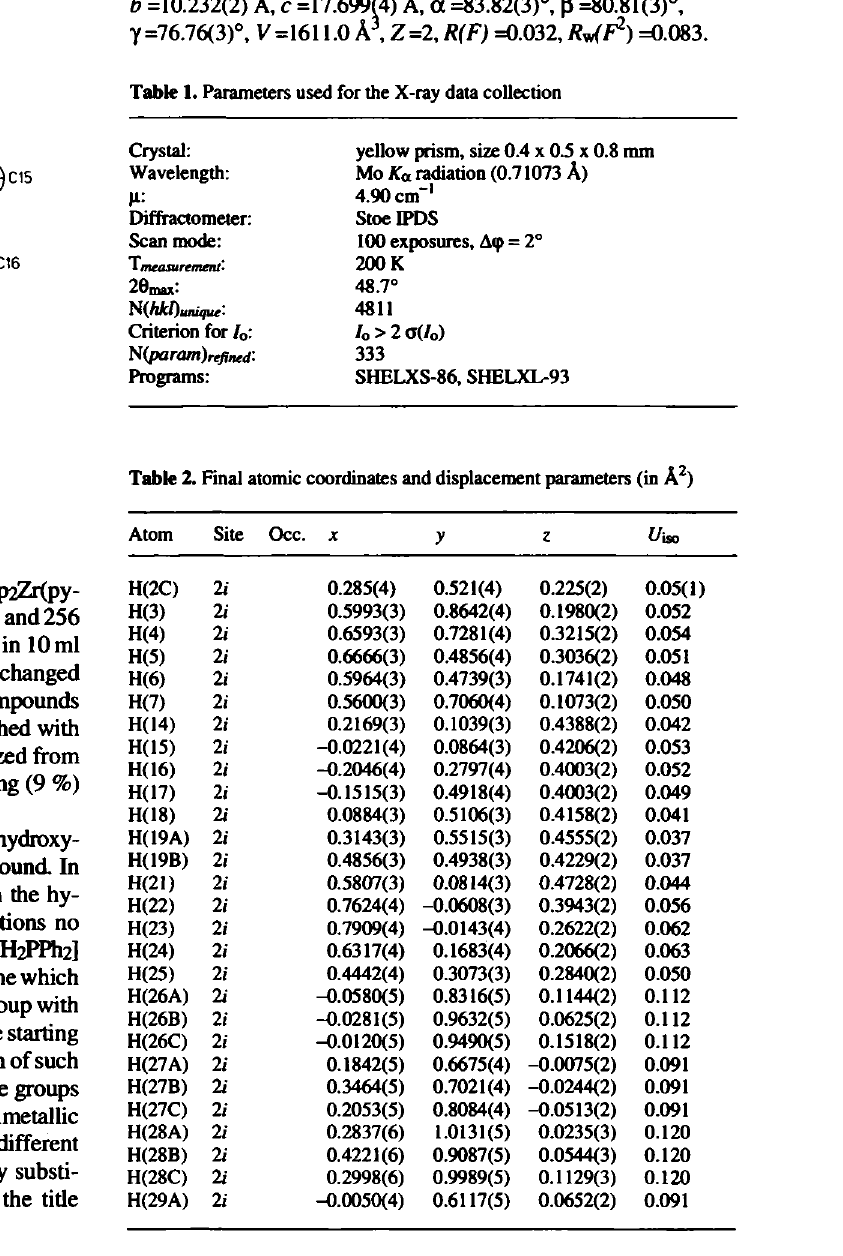
Table 1. Parameters used for the X-ray data collection Crystal: